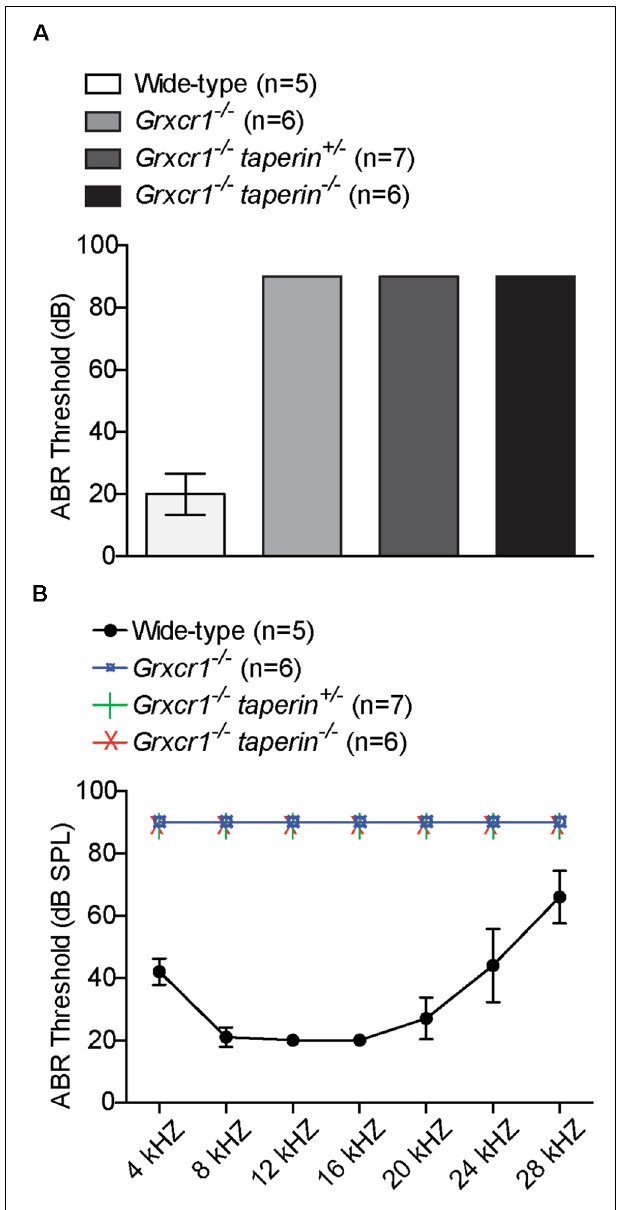
FIGURE 6 | Analysis of hearing function by ABR. (A,B) ABR thresholds for click stimuli (A) and pure tones (B) at the age of 6 weeks. Note the profound hearing loss in Grxcr1 − / − , Grxcr1 − / − taperin + / − , and Grxcr1 − / − taperin − / − mice across the entire frequency spectrum analyzed. p < 0.001 between wild-type and Grxcr1 − / − , Grxcr1 − / − taperin + / − , and Grxcr1 − / − taperin − / − mice (two-way